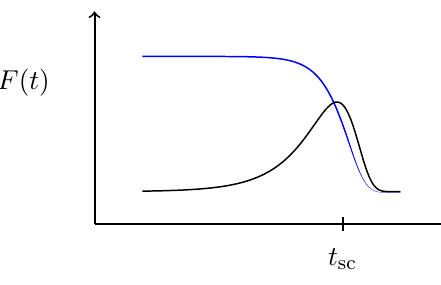
Figure 1 . Sketch of a typical behavior of inelastic OTOC F ( t ) in 2d CFT (black curve) as a function of time, assuming its approximated by a non-vacuum block with e(cid:11)ective dimension (cid:1) e(cid:11) and spin s e(cid:11) . Initially the OTOC grows exponentially with rate (cid:21) = 2 (cid:25) the fast decay is controlled by the quasi-normal modes. In blue we show a typical elastic OTOC. sheet. From the previous section we see that s